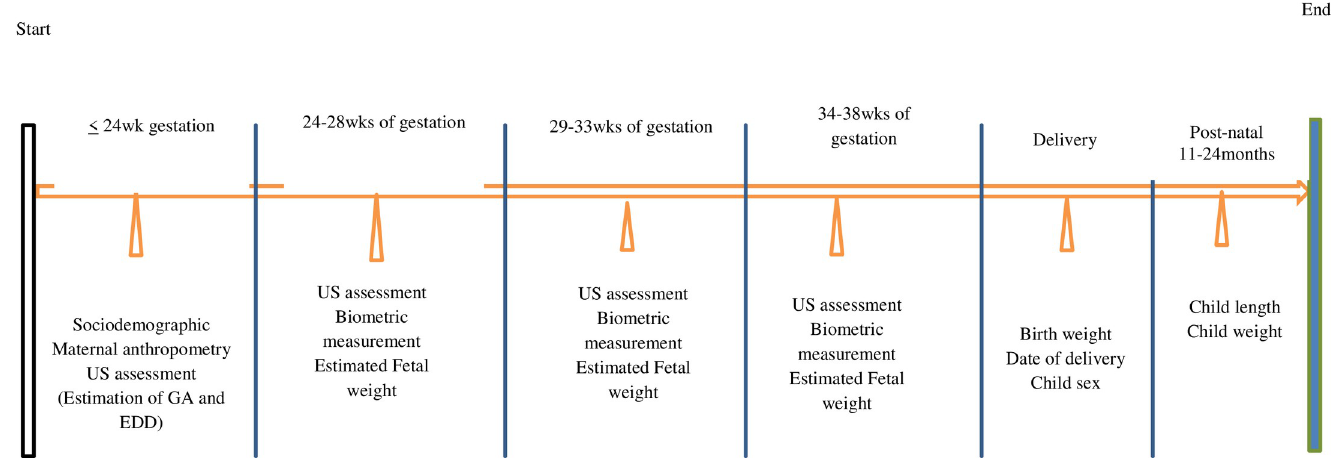
Fig 1. Data collection timeline of the